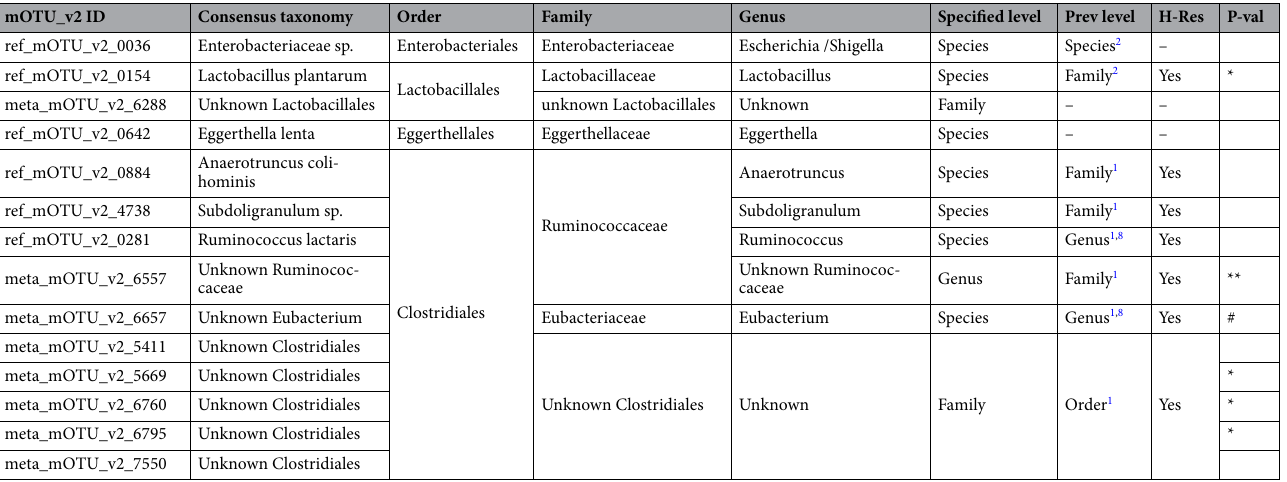
Table 3. The finalist of ICI-response-relevant key microbiota. *: p < 0.05, Wilcoxon’s rank-sum test on differential abundance; **: p < 0.01, Wilcoxon’s rank-sum test; #: p < 0.05, log-rank test on progression-free